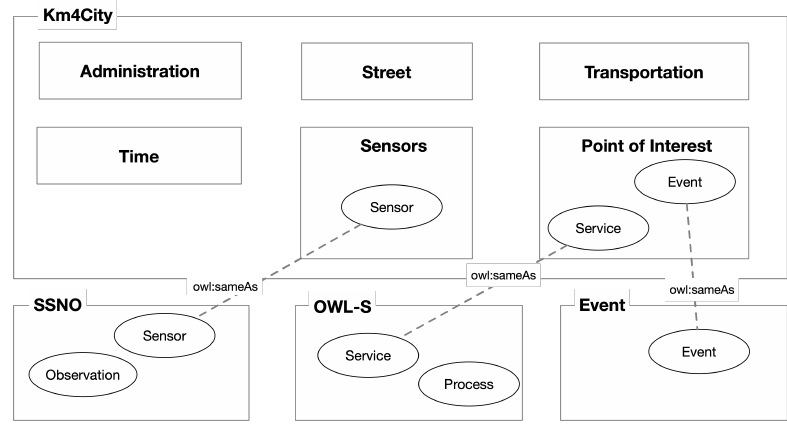
Figure 3. Main modules of the ontological